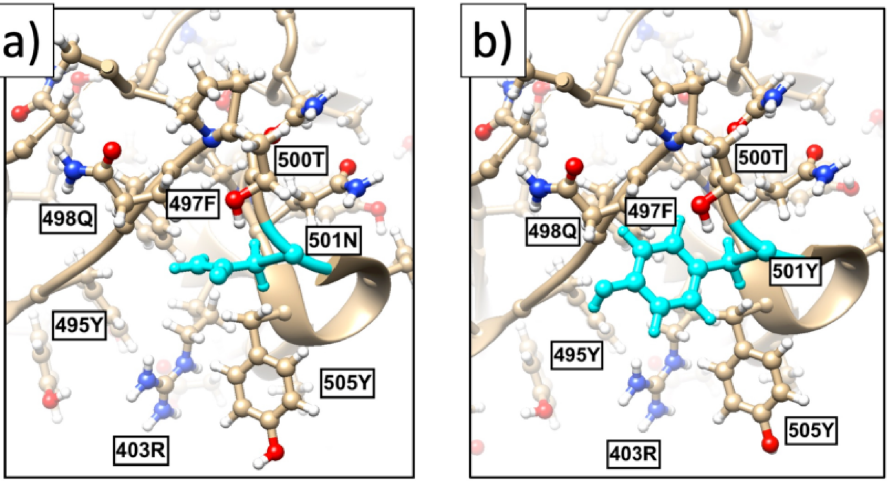
Fig 11. a) The present all-atom structure of the spike protein in the neighborhood of site 501. b) The effect of N ! Y substitution as predicted by Chimera [42]. Besides a small change in the orientation of 505Y, despite the